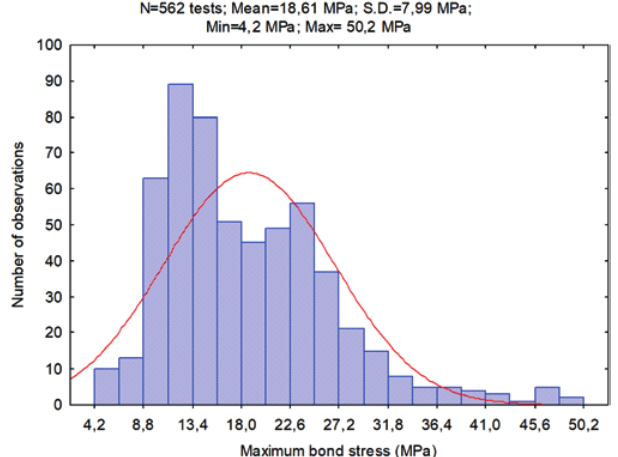
Distribution of the results of maximum bond stress used in ANN